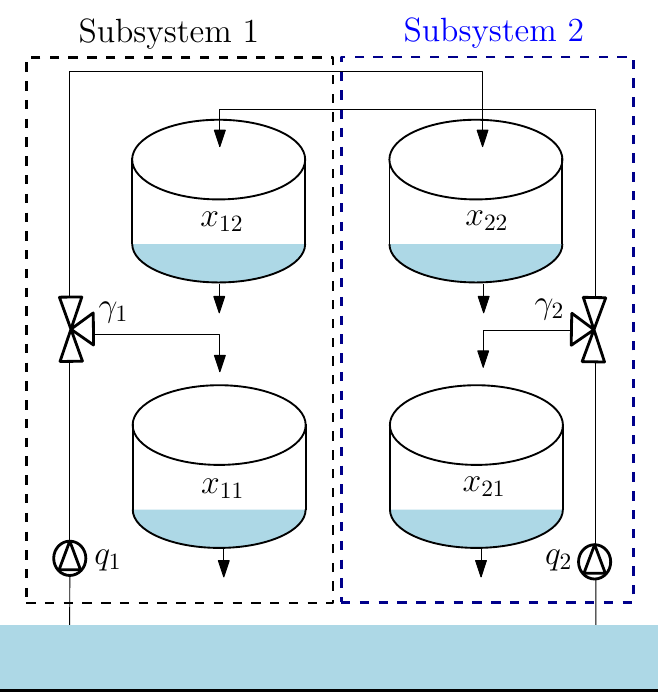
Figure 7. Water tanks with two subsystems interconnected by the